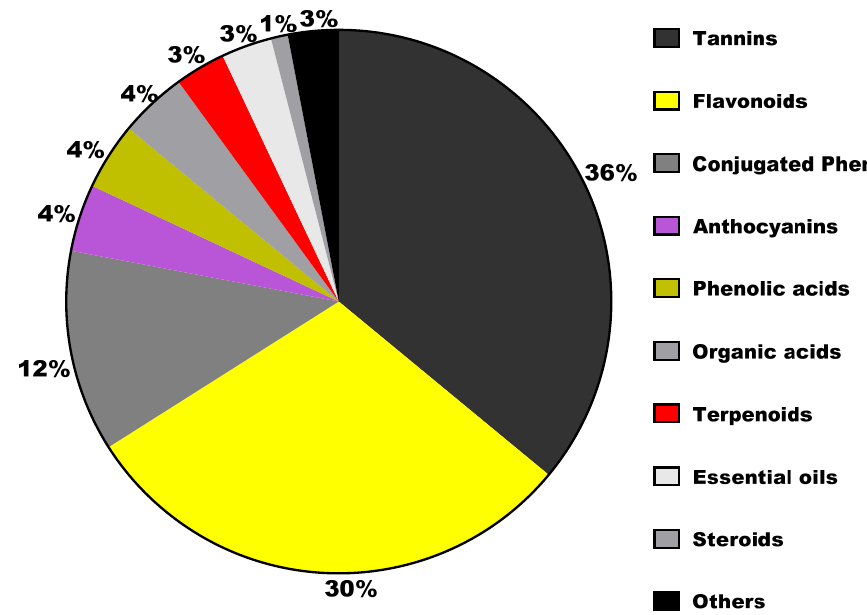
Figure 3. Distribution of 200 phytochemicals from Rhus coriaria into